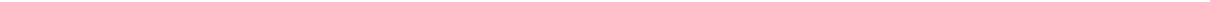
Fig. 3 Representation of color by color-selective neurons in color patches. a Responses of all color-selective neurons averaged across stimuli within each category to images of 8 different hues, together with gray (left-most column) and natural color (right most-column), sorted in the same way as Fig. 2. b Neural representation of colors in the activities of color-selective neurons. Shown are two-dimensional plots of the results of multi-dimensional scaling (MDS) analyses conducted for neurons in three color patches. Responses to each color condition were averaged across all mammal images (humans faces, monkey faces, and mammal bodies; these were selected because color tuning was most consistent between these three categories across all three patches, see Supplementary Fig. 3b). Original color is indicated by a disk of mixed color. c Neural distances of each hue to its two neighboring hues, for all three patches, computed using population responses of color-selective cells. Error bars represent s.d. of 20,000 iterations of bootstrapping. Inhomogeneity was quanti fi ed by computing the ratio between the s.d. of the 8 bars and the mean of the 8 bars: 0.21 ± 0.02 for CLC; 0.12 ± 0.02 for ALC; 0.35 ± 0.02 for AMC ( p < 0.001 between CLC and AMC; p < 0.001 between ALC and AMC; p = 0.0103 between CLC and ALC, 20000 iterations of bootstrapping, see Methods). d Population similarity matrices of 10 color conditions in three color patches. A 10×10 matrix of correlation coef fi cients was computed between responses of all color-selective neurons averaged across objects. e For fi ve different types of objects: grapes, watermelon, birds, gratings, and rubik ’ s cube, the number of AMC cells preferring each of the eight hues was counted. In all fi ve cases, the distribution was signi fi cantly different from homogeneity (chi- square test: p < 0.001; χ 2 (7) = 26.3, 28.6, 31.0, 38.6 and 28.4,